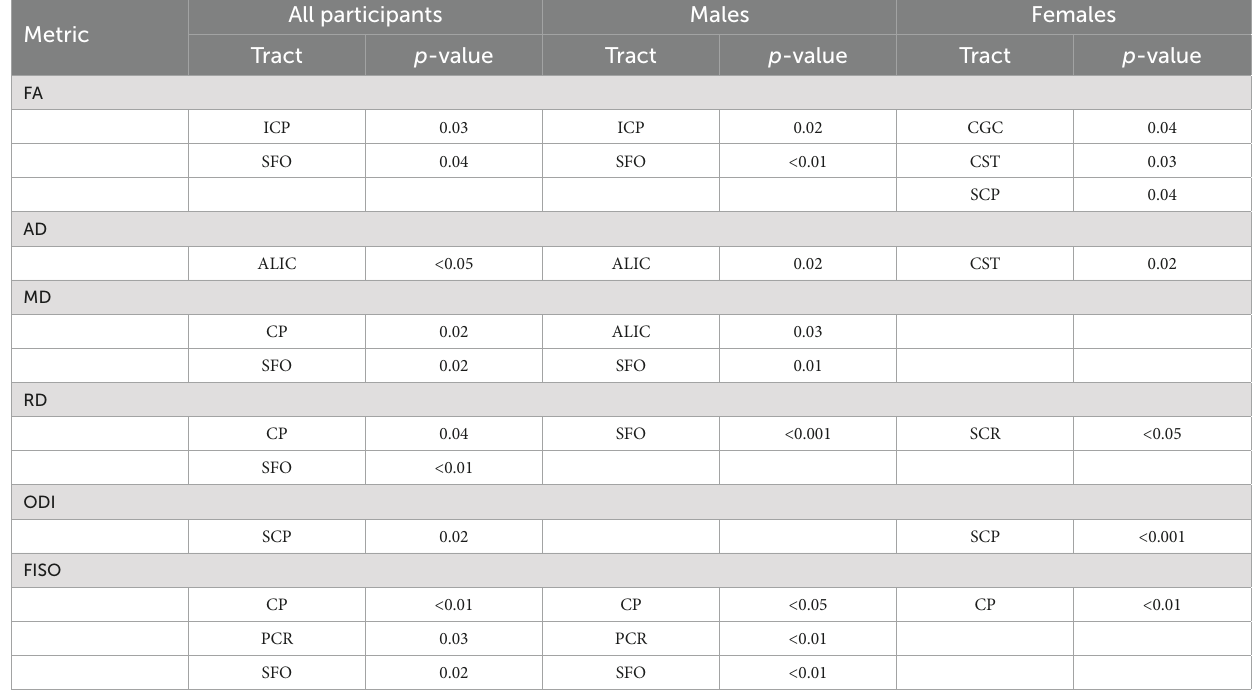
TABLE 3 p -values for the significant tracts when comparing SOR to non-SOR for all participants and for males and females separately (see Figures 3–6).